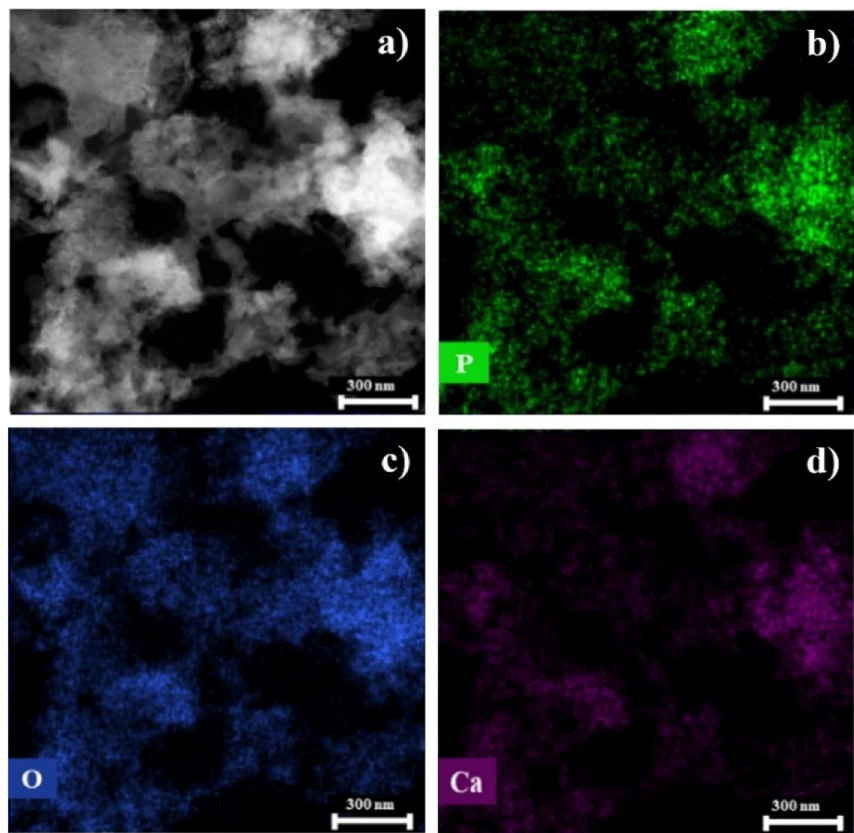
Fig. 4 Dark‑Field TEM image ( a ) and STEM‑EDS analysis ( b ‑ d ) of BCM2